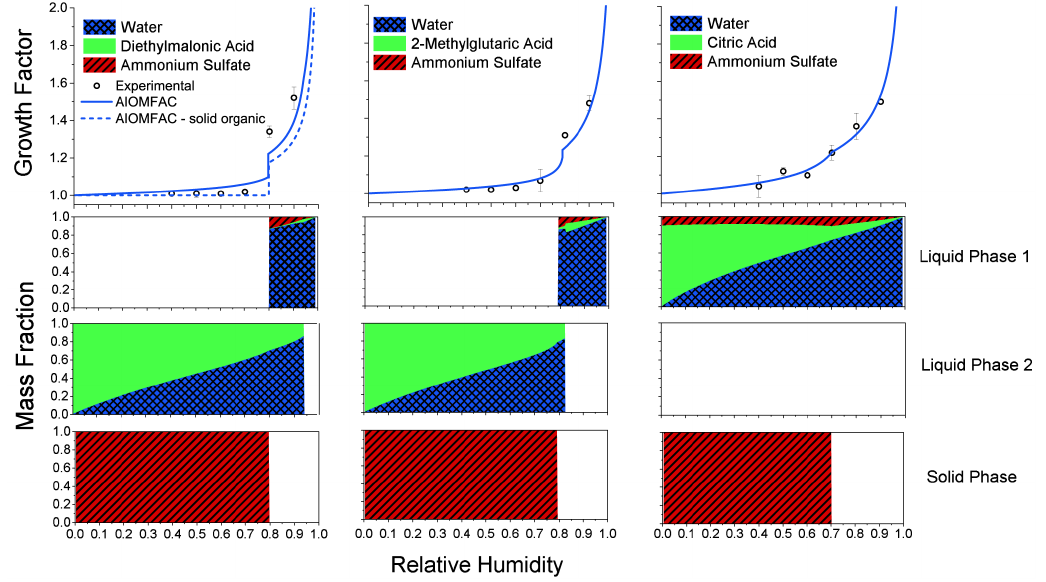
Figure 1. Top panels: Measured and AIOMFAC-predicted hygroscopic diameter growth factors for (a) diethylmalonic acid–ammonium sulfate particles, (b) 2-methylglutaric acid–ammonium sulfate particles, and (c) citric acid–ammonium sulfate particles, with dry or- ganic:inorganic mass ratios of 2:1 for all systems. The black circles indicate the average growth factor measured across ten experiments and error bars indicate the standard deviation of the measured growth factors. Panels below the hygroscopic growth curves indicate the AIOMFAC-predicted composition of each of three possible phases present in the particles (liquid phase 1, liquid phase 2, and a solid phase) as a function of relative humidity. Empty boxes indicate that no second liquid phase is